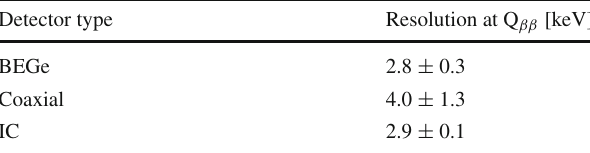
Table 2 FWHM resolutions at Q ββ for each DTD, reported as exposure-weighted averages. The uncertainty is given by the standard deviation among the detector